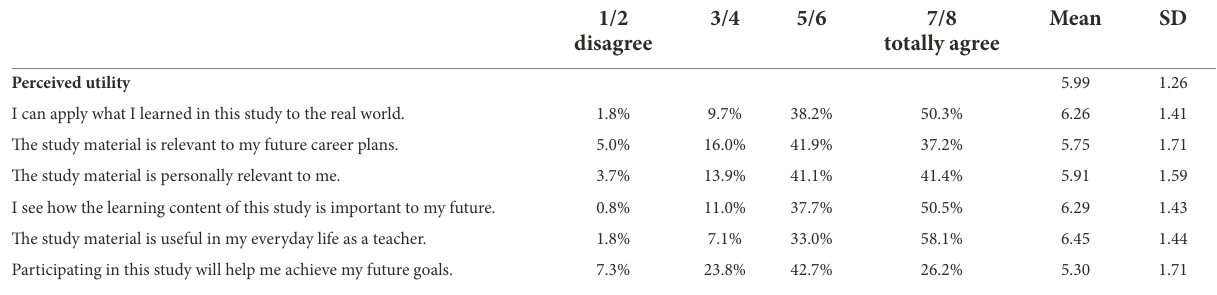
TABLE 3 User experience of utility value as indicator for relevant practice